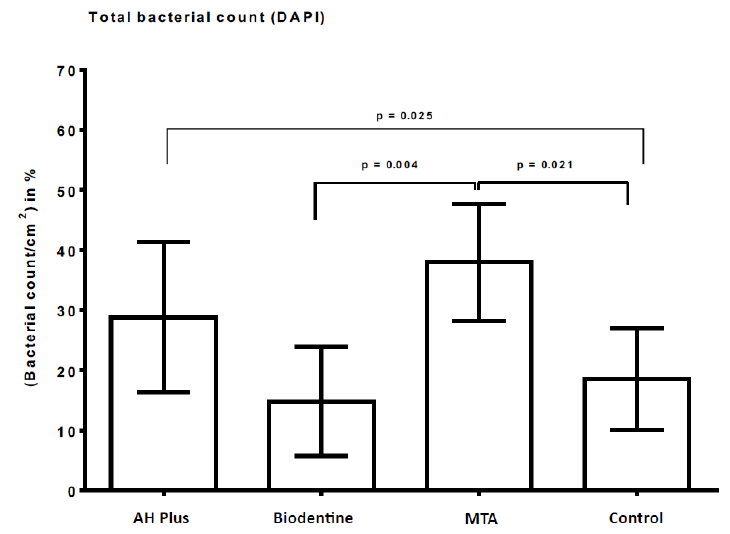
Figure 2. DAPI staining and fluorescence microscopy to visualize adherent microorganisms on AH Plus, Biodentine, MTA, and bovine dentin. The graphs represent the percentage of adherent microorganisms, which were evaluated by the DAPI staining under the fluorescence microscope (FM). Bovine dentin served as a negative control, while AH Plus, Biodentine, and MTA served as material test surfaces. Standard deviations and the p values of the significantly different data are marked on the graphs.